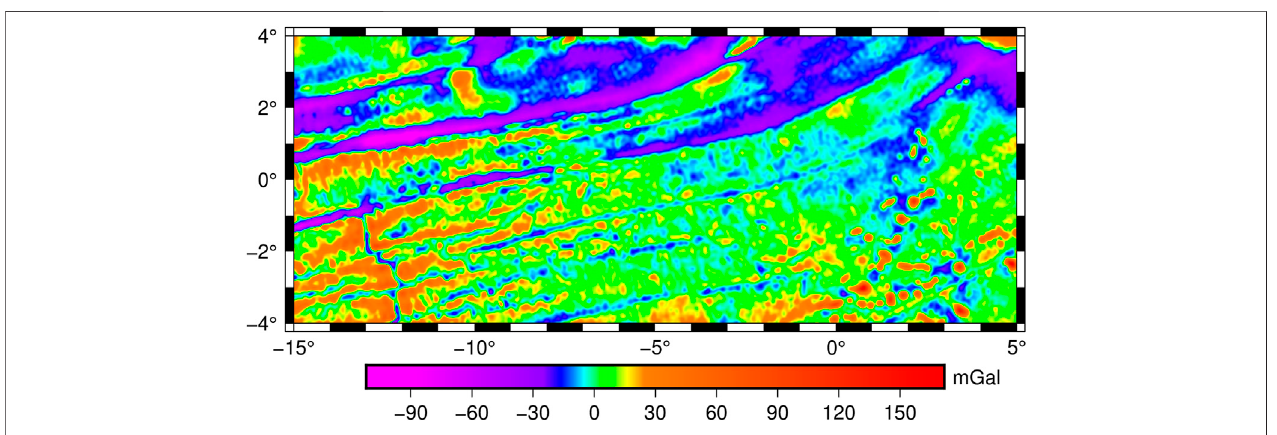
FIGURE 4 | Inverted gravity anomaly